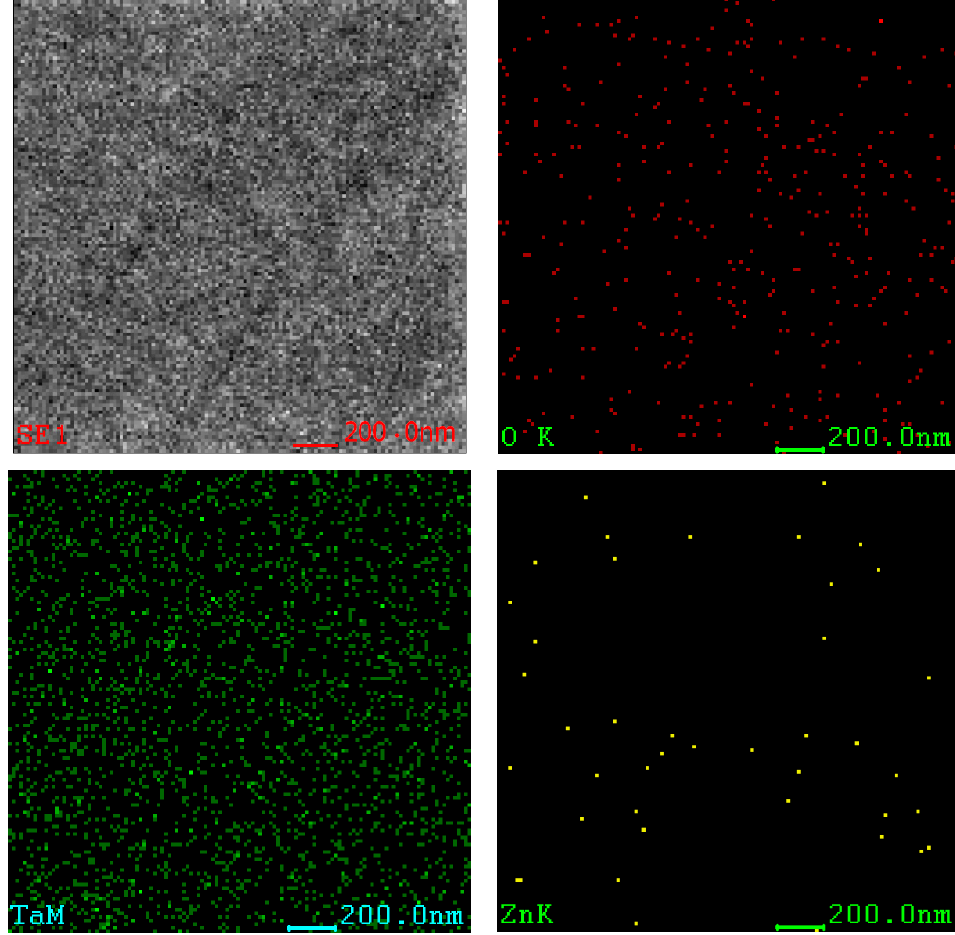
Figure 5. Element mapping images of ZnO-Ta x O y coating.